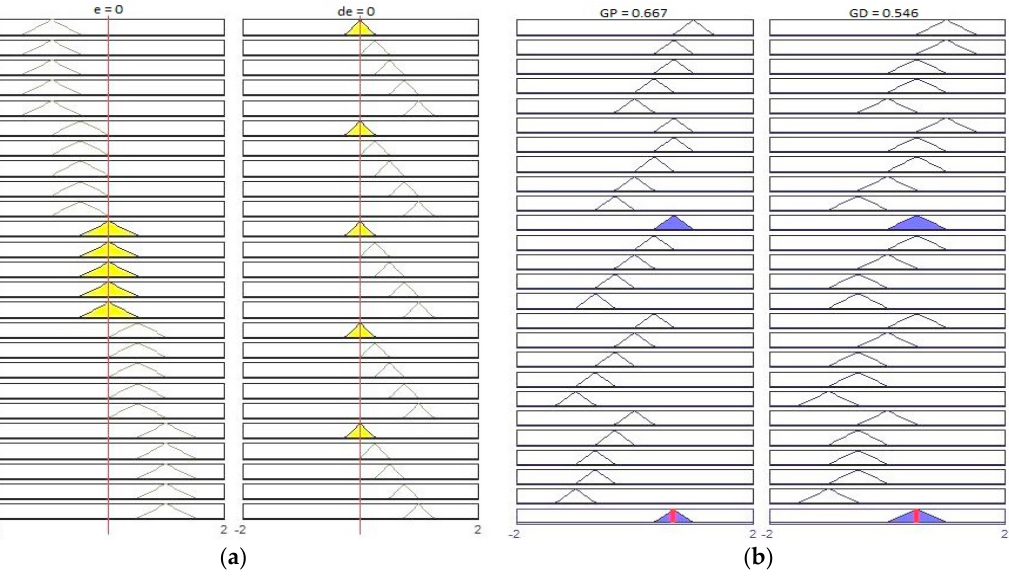
Figure 3. ( a ) Input rules for error and the derivative error of the fuzzy-based Proportional Derivative (PD) controller; ( b ) the output rules for the fuzzy-based PD controller.